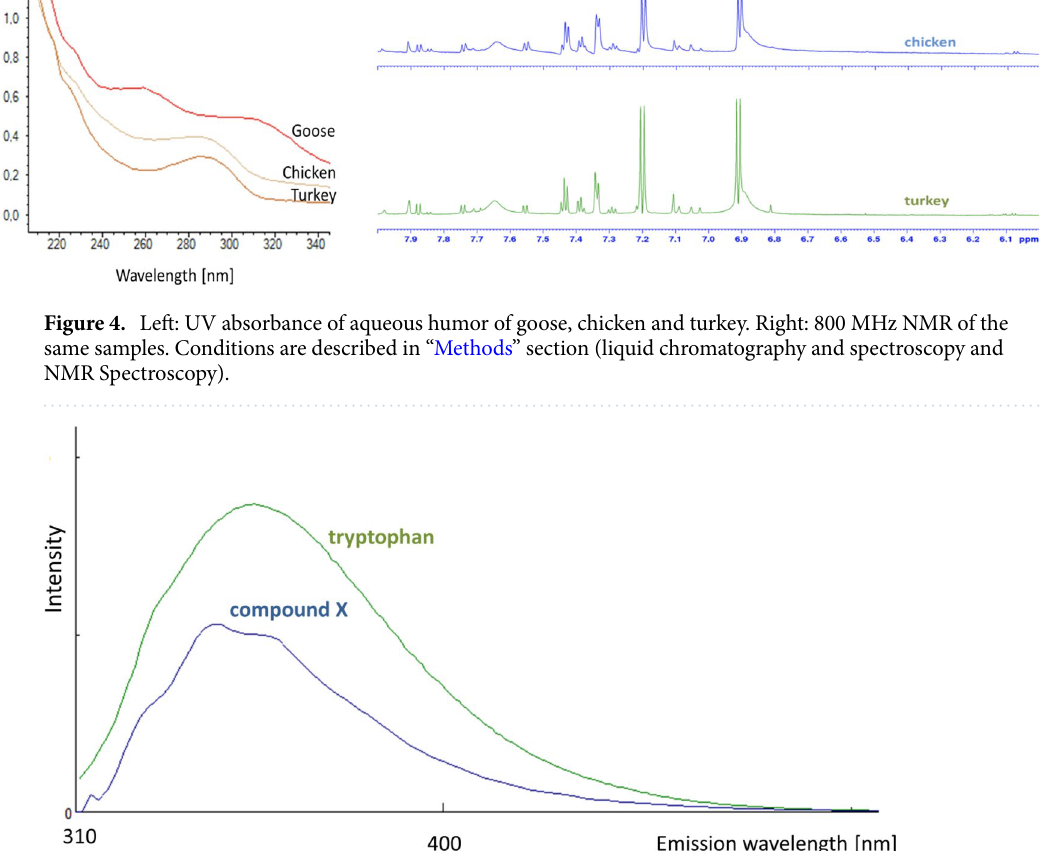
Figure 5. Fluorescence spectra overlay in 2D of “compound X” and tryptophan. Conditions are described in “Methods” section (liquid chromatography and spectroscopy).